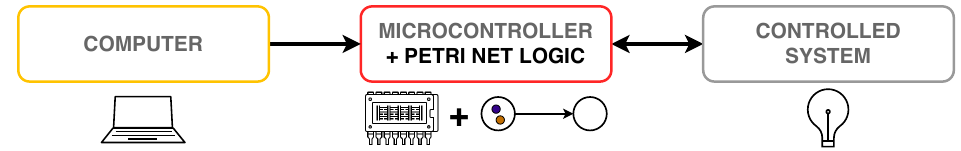
Figure 1. Basic scheme of proposed solution—Petri net’s logic in microcontroller [26].